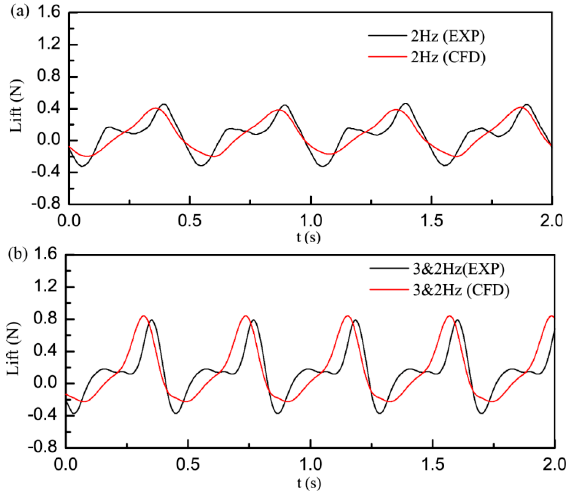
Figure 14. Comparison between lift curves of the flapping wing rotor measured in ( a ) 2 Hz case; ( b ) 3&2 Hz case.